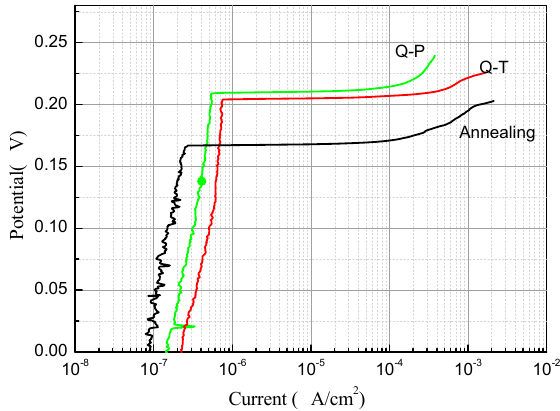
Figure 10. Polarizing curves of the investigated materials by different heat treatments.